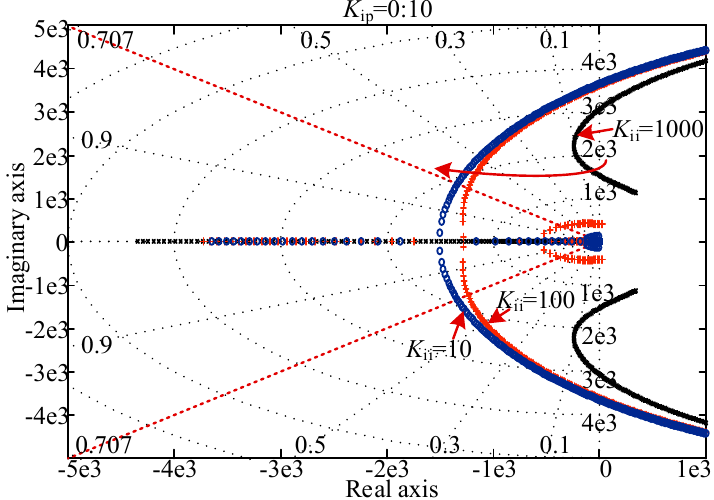
Figure 5. Root locus diagrams with different parameters of G i (s).